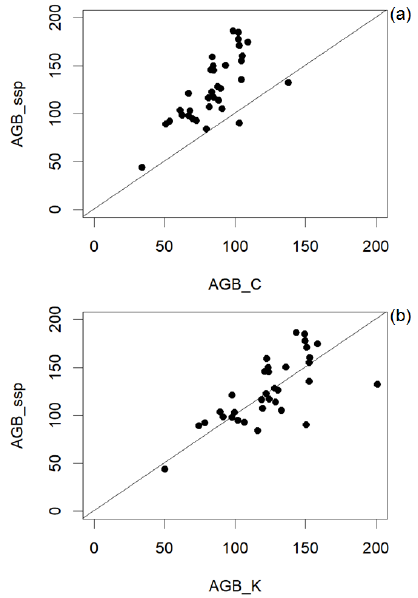
Figure 3. Correlation plot for field-estimated AGB with species-specific equations (AGB_ssp) versus the pantropical equations of Chave et al. [56] (AGB_C) ( a ), and Komiyama et al. [44] (AGB_K) ( b ).